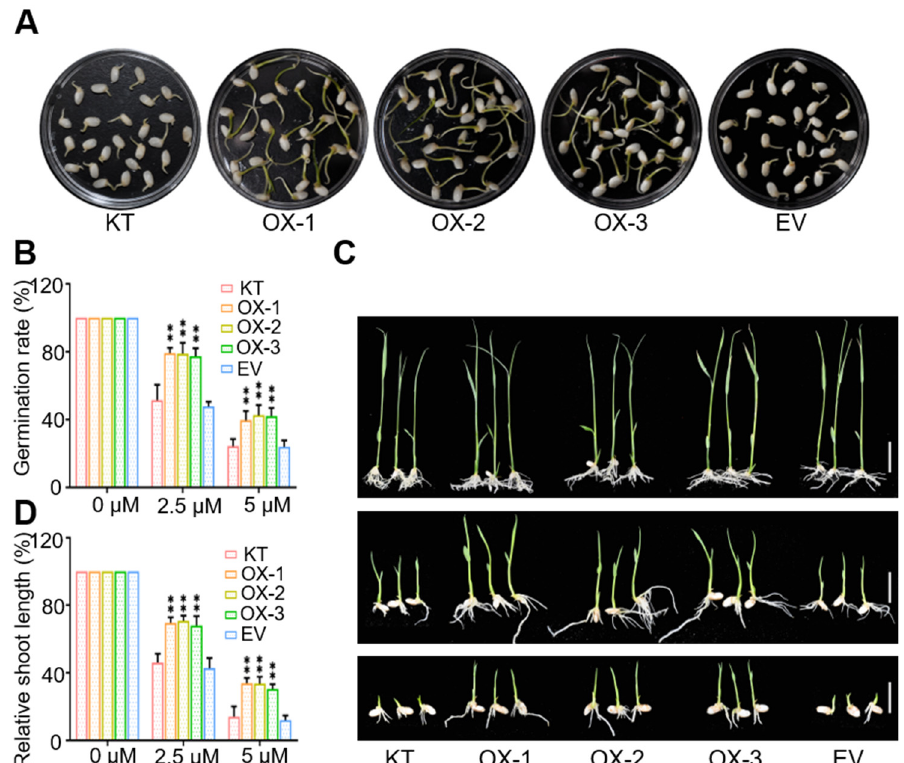
Figure 5. OsWRKY50 ‐ OX lines showed hyposensitivity to ABA response. ( A ) Germination pheno ‐ types of KT, OX ‐ 1, OX ‐ 2, OX ‐ 3, and EV plant seeds. The seeds were germinated on MS medium containing DMSO (dimethyl sulfoxide), 2.5 μ M, or 5 μ M ABA. The seeds shown in ( A ) were sup ‐ plemented with 2.5 μ M ABA for five days. ( B ) Germination rates were measured in accordance with cotyledon greening emergences as shown in ( A ). ( C ) Phenotypes of rice seedlings treated with ex ‐ ogenous ABA. Two ‐ day ‐ old germinated seeds were transferred to MS medium containing 0, 2.5 μ M, or 5 μ M ABA for four days. The bars represent 2 cm. ( D ) Statistical analysis of the relative shoot length under ABA treatment. Error bars indicate ± SD ( n = 3). Three biological replicates were per ‐ formed with 20 plants in each genotype. ** p < 0.01 (Student’s t ‐ test).